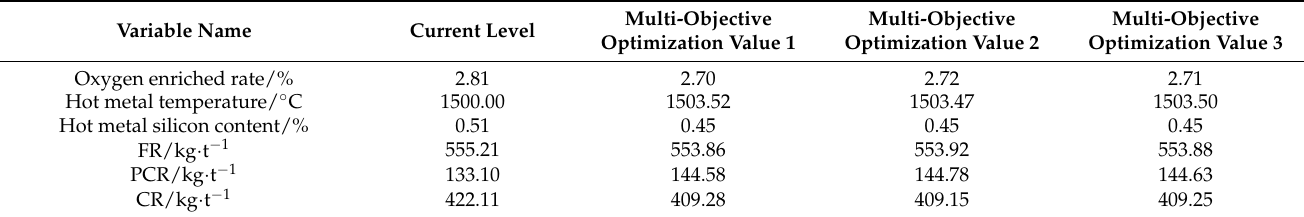
Table 3. Multi-objective optimization